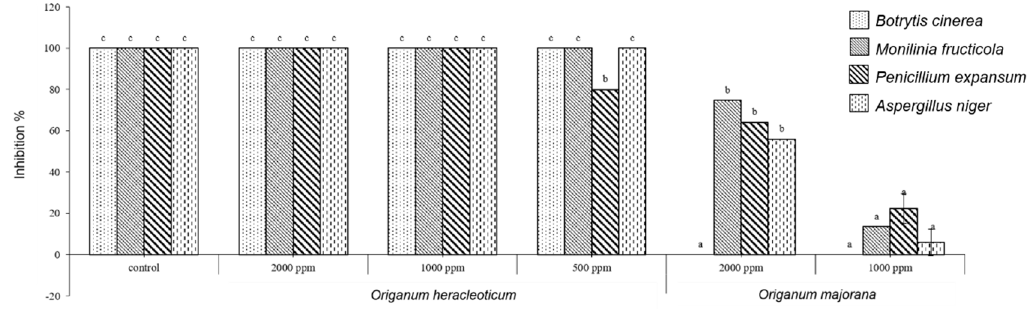
Figure 2. Antifungal activity of O. heracleoticum and O. majorana EOs. Bars with di ff erent letters for each tested fungi indicate mean values significantly di ff erent at p < 0.05 according to Tukey B test between di ff erent tested concentrations. Data are expressed as mean ± SDs.